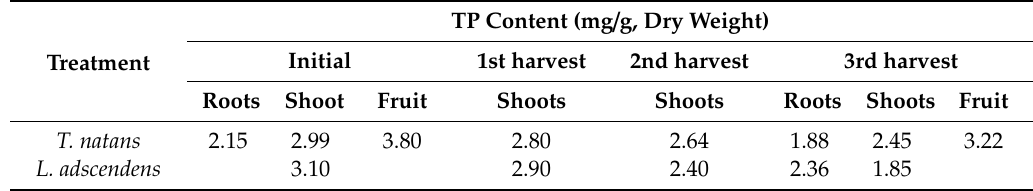
Table 3. Total phosphorus (TP) concentration and total uptake of floating aquatic macrophytes after 60 days of treatment in swine manure wastewater.